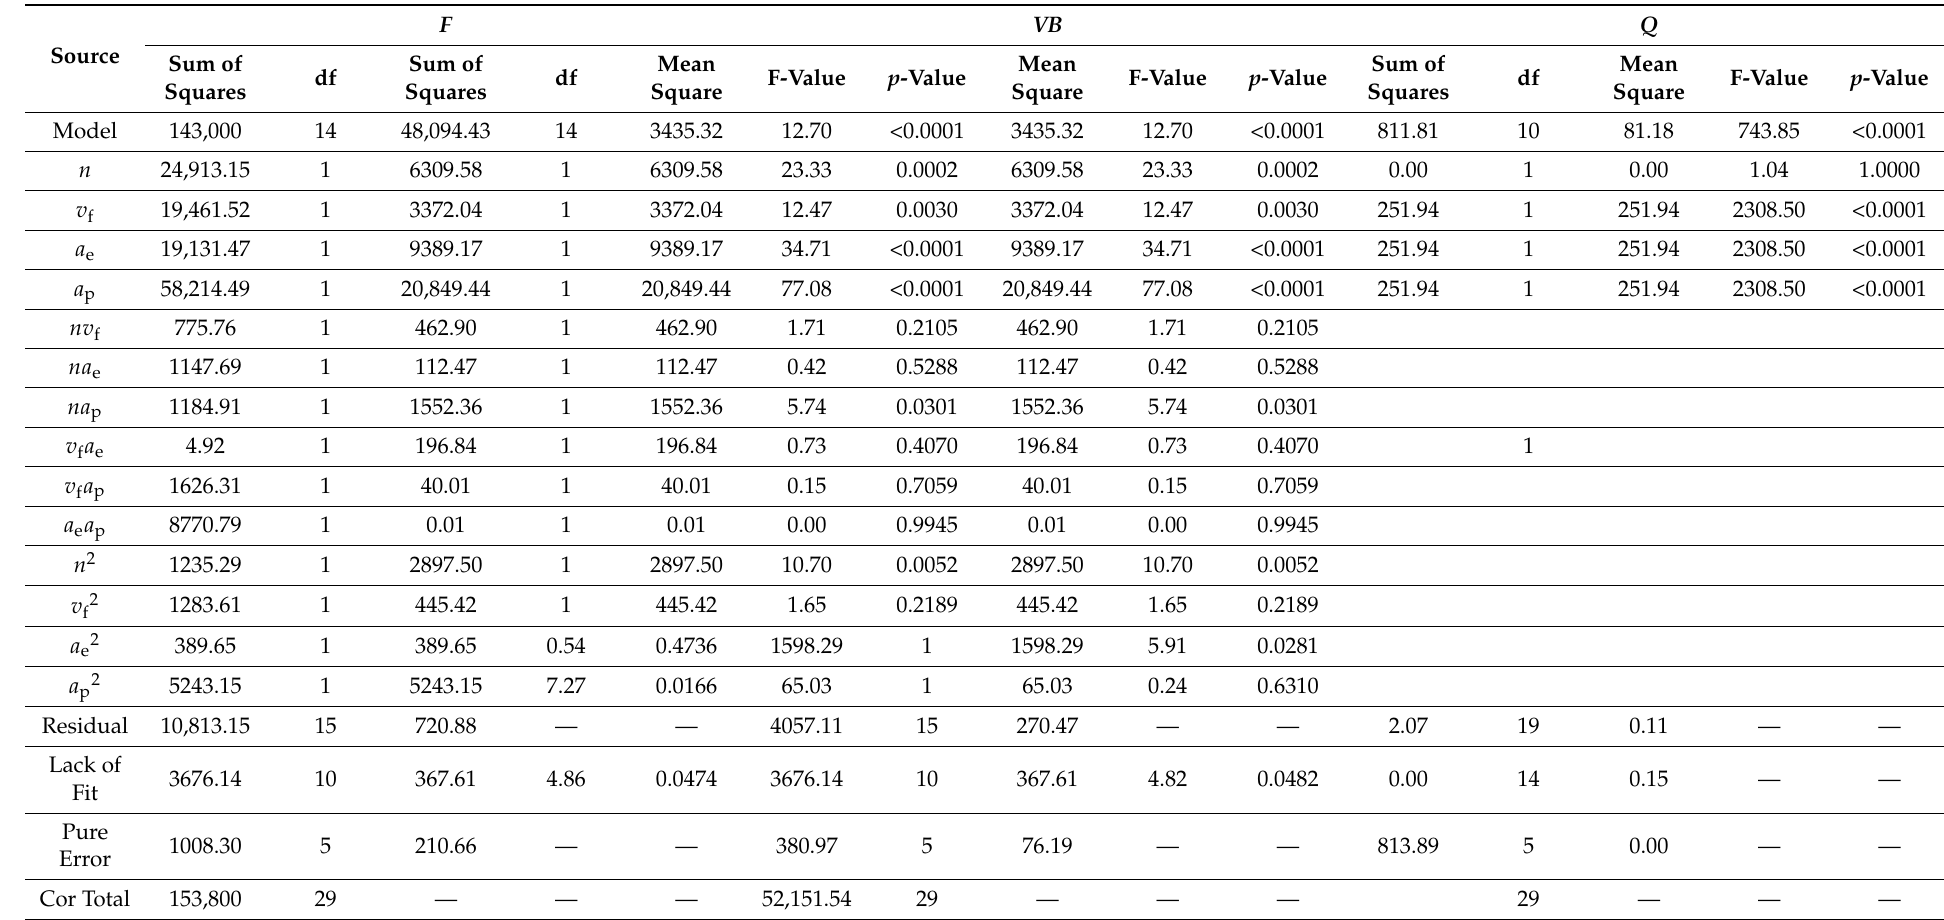
Table 5. Analysis of variance of regression prediction